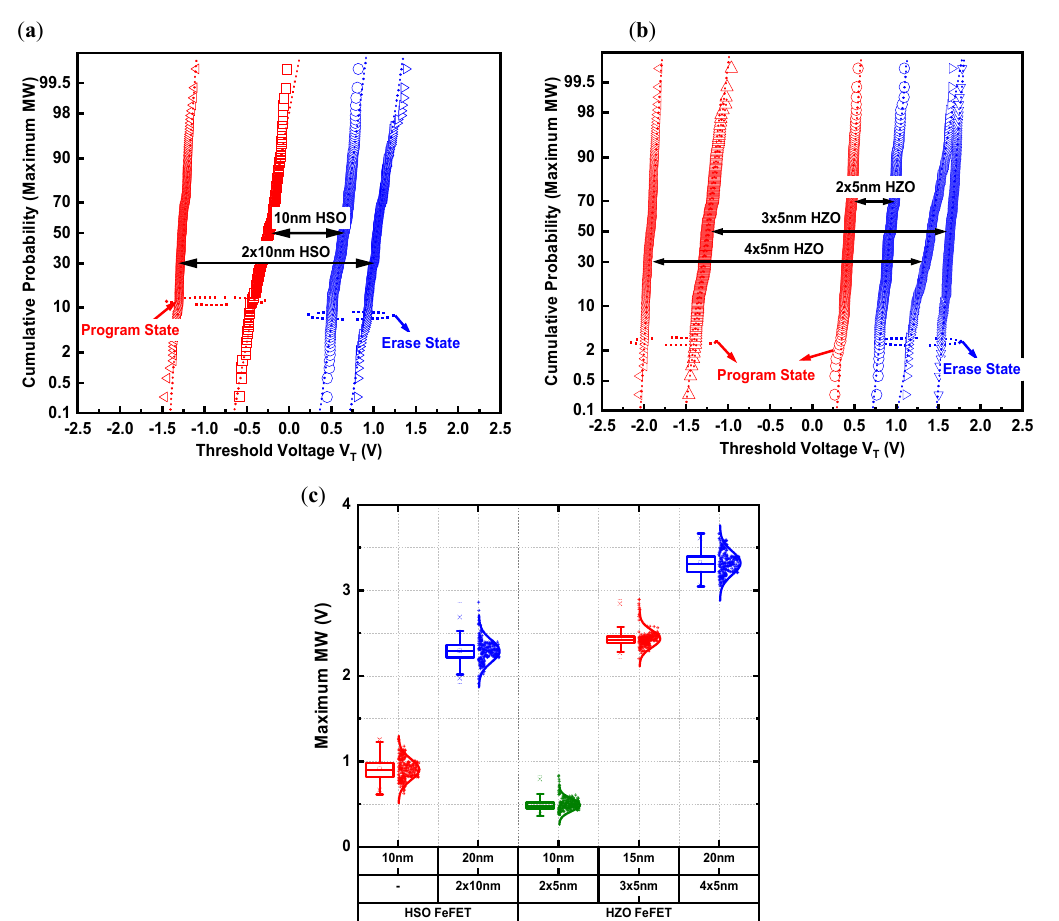
Figure 10. The global wafer PG/ER V T distribution, based on the optimal conditions shown in Figure 8, independent of ferroelectric/laminate stack with the cumulative probability for ( a ) HSO, ( b ) HZO, and ( c ) obtained maximum MW in relation to the ferroelectric/laminate thickness. Reproduced with permission from [17] T. Ali et al., IEDM; published by IEEE, Copyright 2019, IEEE.